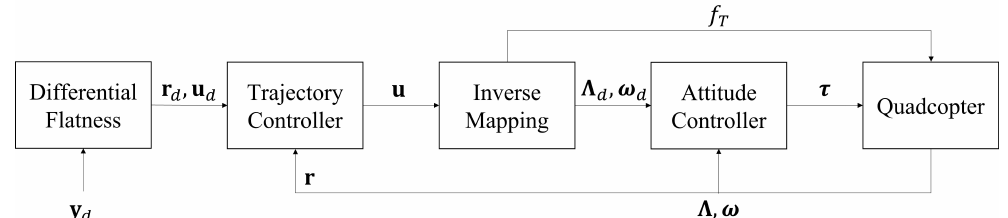
Figure 2. Flowchart of the trajectory